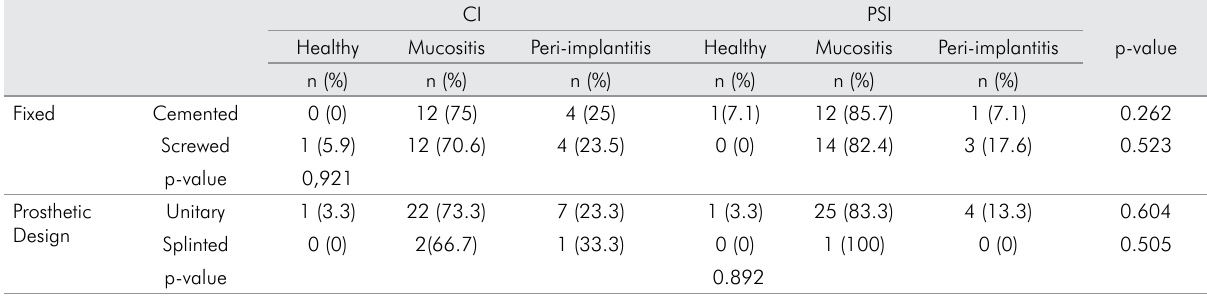
Table 4. Prevalence of mucositis and peri-implantitis using the clinical criteria of pockets ≥ 5 mm according to implant system (CI vs. PSI), fixation and prosthetic design.